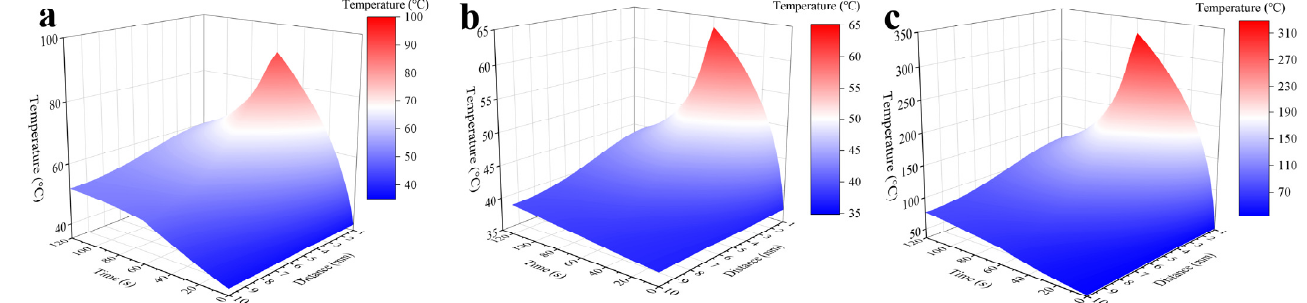
Figure 5. Temperature distribution at the horizontal thermometric sequence of the highest temperature point near ablation antenna. ( a ) Temperature distribution from muscle; ( b ) Temperature distribution from fat; ( c ) Temperature distribution from the bone.